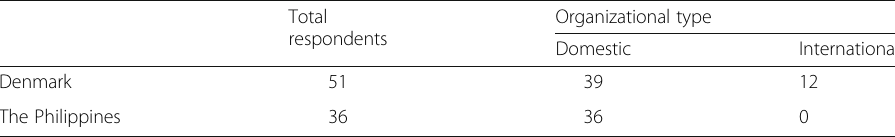
Table 2 Respondents ’ location and organizational type